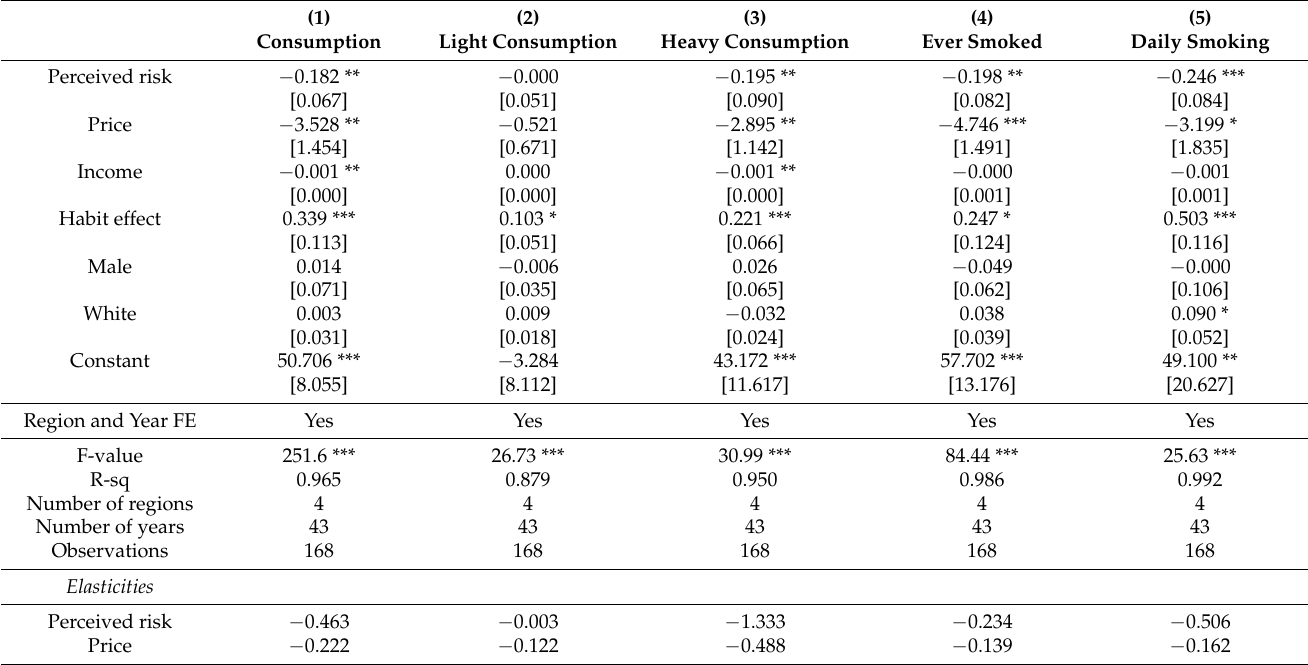
income has a negative effect on consumption, showing that an increase in regional income is associated with a decrease in the regional percentage of high school seniors that consumed at least one cigarette per day. This is consistent with the evidence that people with a lower socioeconomic status tend to smoke more [30]. Habit agrees with previous findings [31] and reinforces the intuition that previous consumption increases current consumption. The coefficients for gender and race are not statistically significant. Column (2) shows the results for light consumption, which indicate that risk and price do not have a significant impact on this type of regional smoking behavior. Habit is the only significant determinant in this specification, suggesting that previous regional consumption also reinforces current light regional consumption of cigarettes. Table 2. Determinants of smoking behavior among U.S. high school seniors.